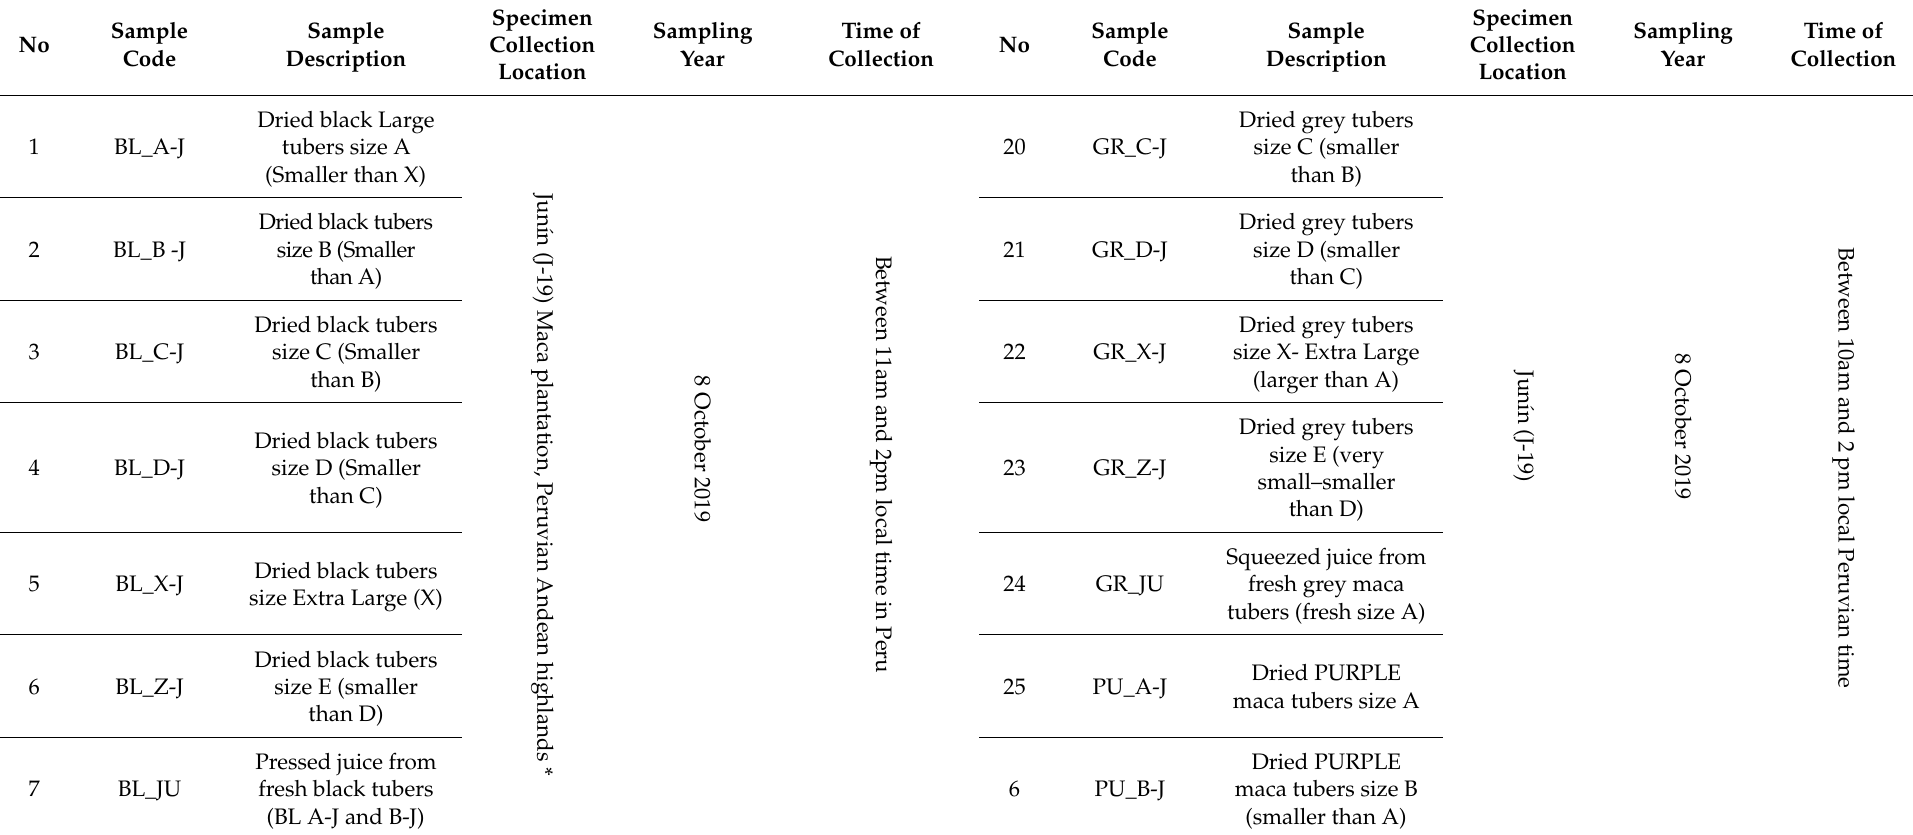
Table 5. Plant material: coding, description and sampling details prior to delivery to Laboratory